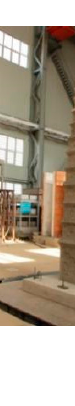
( b ) Figure 4. SMA-SPDS installation setup diagram. ( a ) SMA-SPDS connection; ( b ) SMA-SPDS installa- tion. As the selected material of the model is brick masonry, its bearing capacity and other parameters are basically the same as those of the prototype structure, which is desirable. According to Buckingham theory and dimensional analysis, the similarity relationship between the model and prototype structure is calculated to obtain the similarity coeffi- cients of this test, as shown in Table 1. Table 1. Model similarity relation table. Similar Physical Quantity